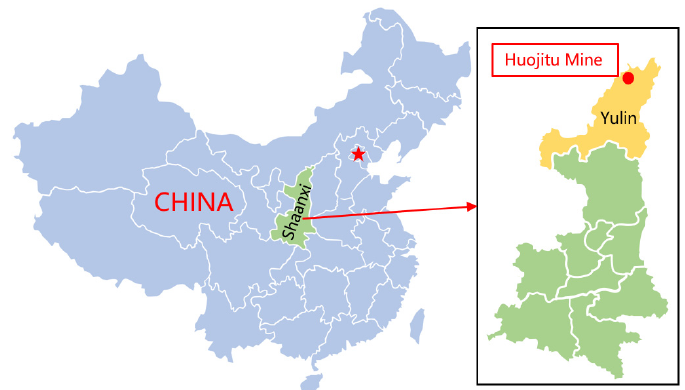
Figure 1. Location of the Huojitu coal mine.